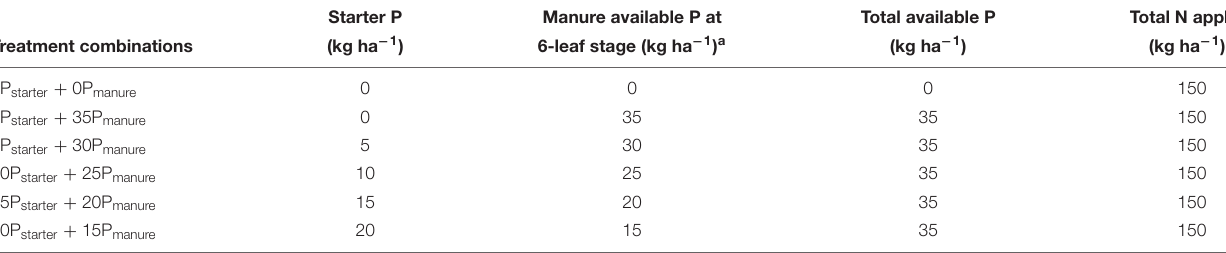
TABLE 3 | Description of the six combination of starter P and manure P treatments. Starter P Manure available P at Total available P Treatment combinations